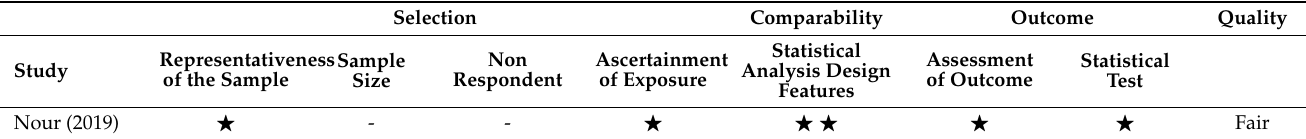
Table 3. Results of the critical appraisal of the included studies using the Newcastle—Ottawa Scale (a) for cross-sectional studies.